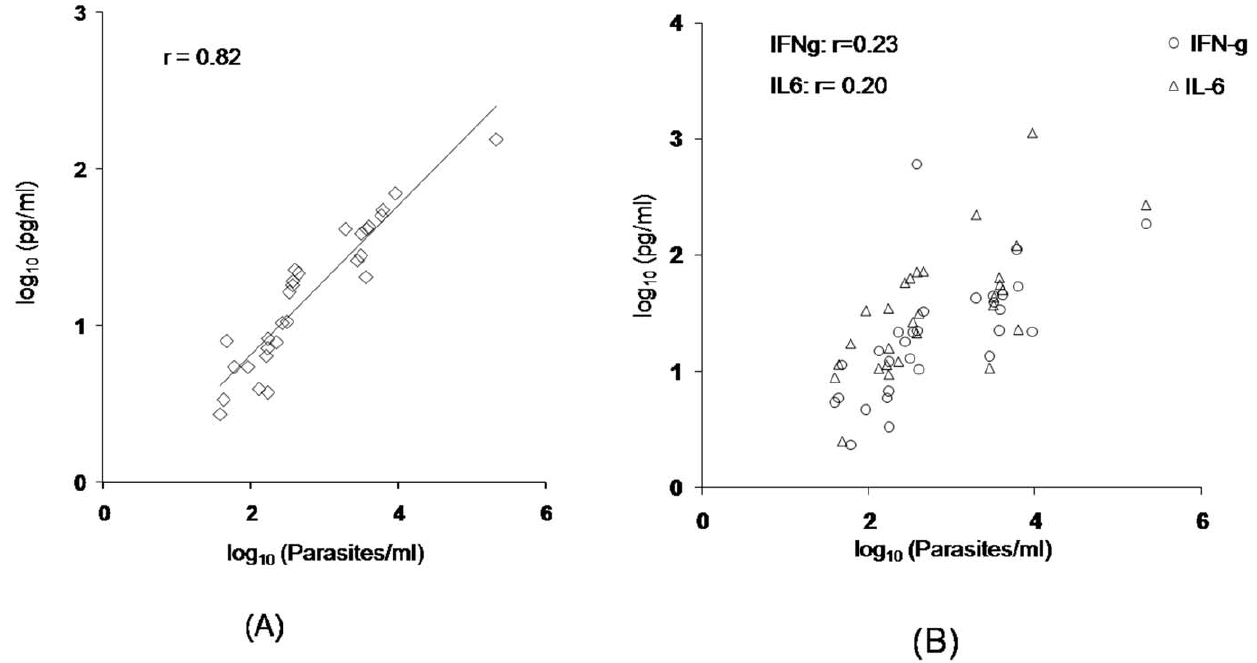
Figure 3. Comparative assessment of IL-10, IFN- c , IL-6 and parasitic load in blood samples of VL patients. The serum levels (pg/ml) of IL10 (Panel A) and IFN- c and IL-6 (Panel B) were measured by CBA and parasite load (Parasites/ml) determined by real-time PCR. Diagonal line represents linear regression.